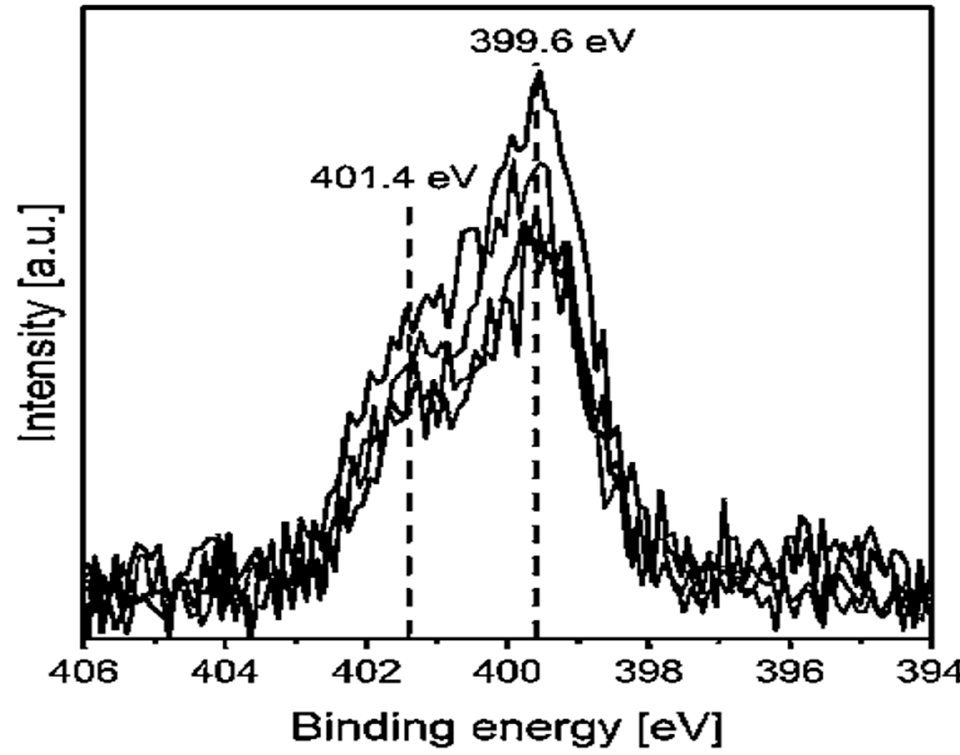
Figure 4. N1s spectra of 3APPA samples grafted with TiO 2 . Reprinted from [92] with permission from Elsevier.